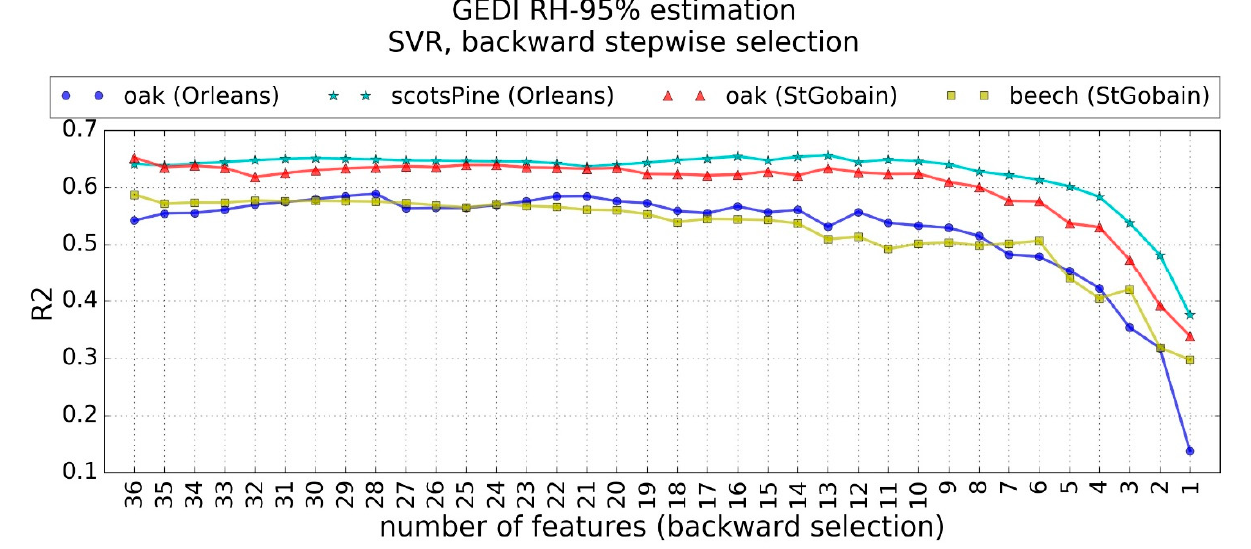
Figure 7. Coefficient of determination (r 2 ) of dominant height estimation (using GEDI RH95% for model training and validation using a K-fold cross-validation), evolution with the number of features selected with a backward stepwise selection (starts with all 36 features and ends with 1 remaining feature).